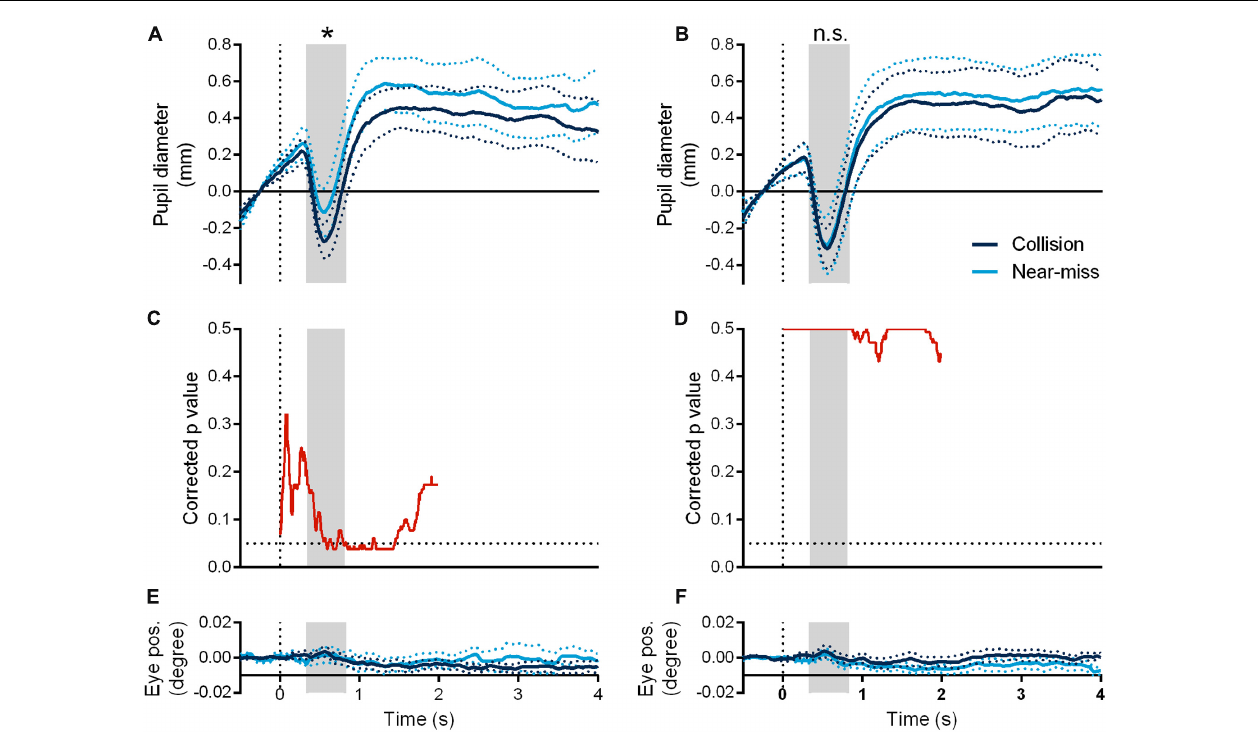
FIGURE 3 | Time courses of pupil diameters in the looming (A) and receding conditions (B) and their corresponding horizontal eye gaze positions (E,F) . Corrected p -value of permutation test of pupil diameter discrepancy between the collision and the near-miss spheres in the two conditions (C,D) , respectively. The gray area indicates the time duration ranging from 340 ms to 820 ms after the onset of the sphere. ∗ p < 0.05. The dotted lines represent one standard error of the